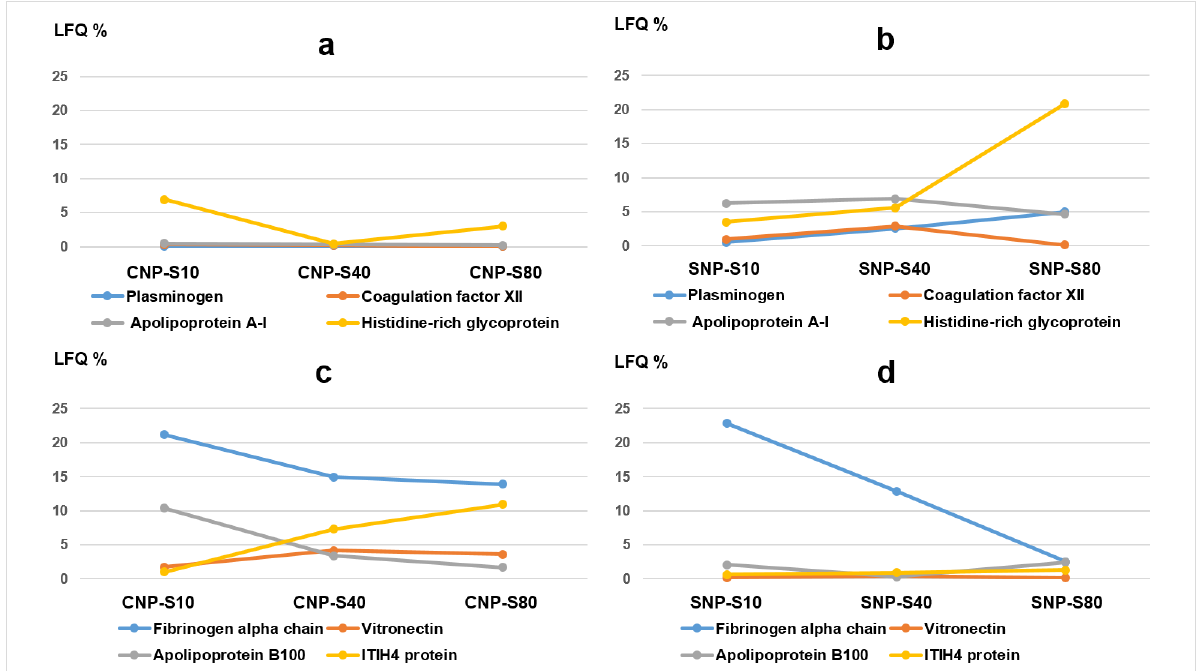
Figure 6: Relative concentration of proteins on small silica (SNP-S) and carbon (CNP-S) nanoparticle coronas at plasma concentrations of 10, 40 and 80%. a–d): semiquantitative protein abundance – comparison between CNP-S and SNP-S coronas. The percentages were calculated based on the total LFQ intensity in each sample.